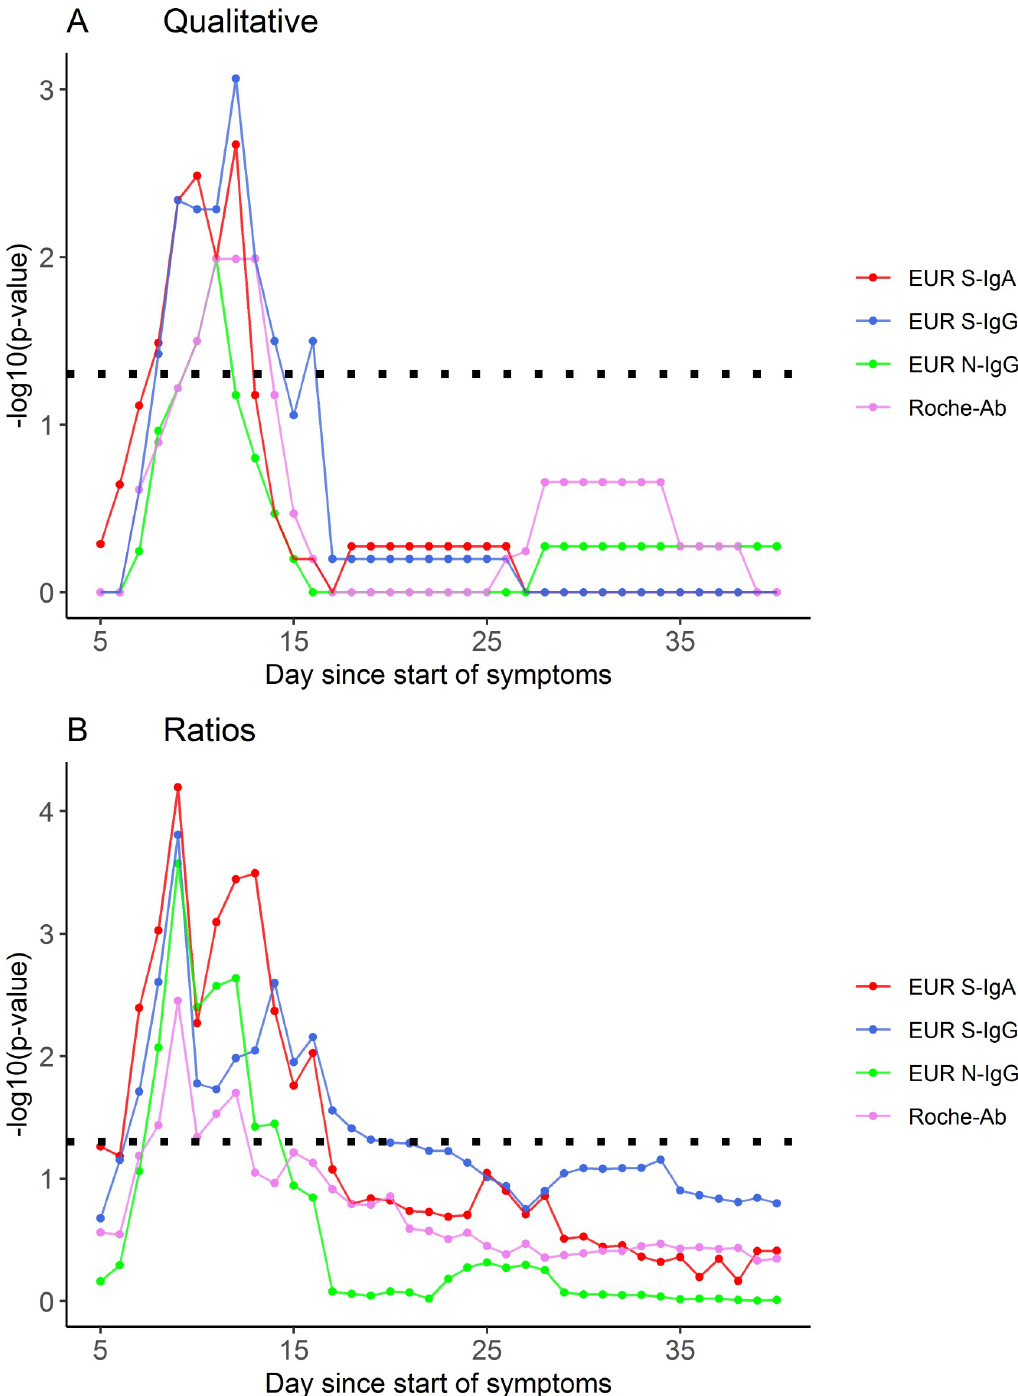
Fig 3. p-values of the differences between non-ARDS patients and ARDS patients for the four immunoassays at different time points. The dotted line represents a p-value of 0.05. (A) Differences in qualitative values. (B) Differences between mean signal